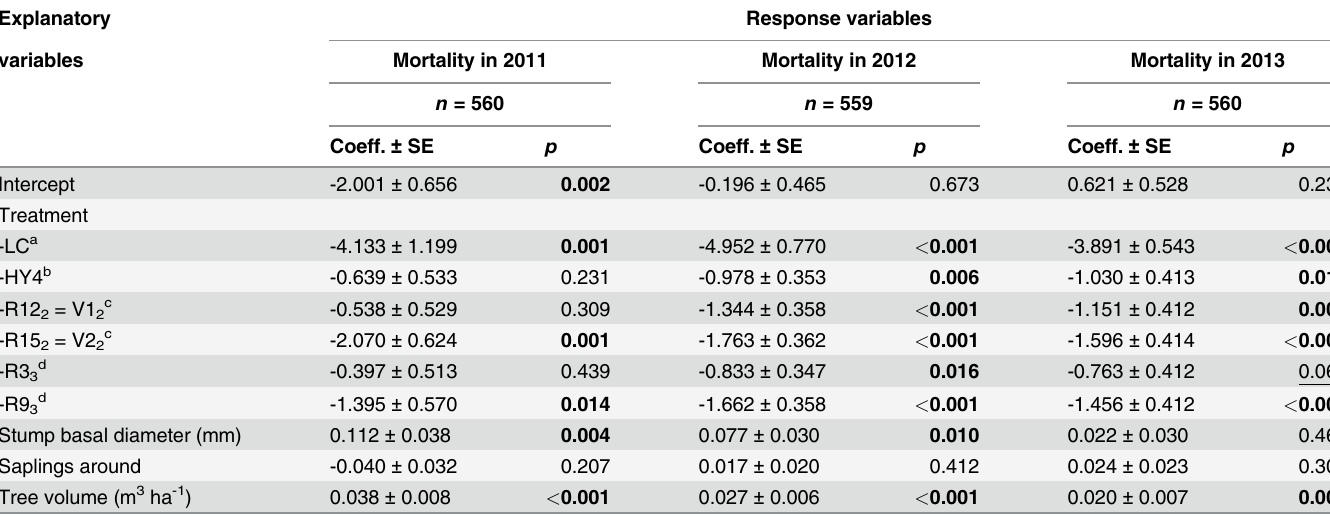
Table 4. Differences in Mortality of Birch Stumps between the C . purpureum Strain R5 3 and Other